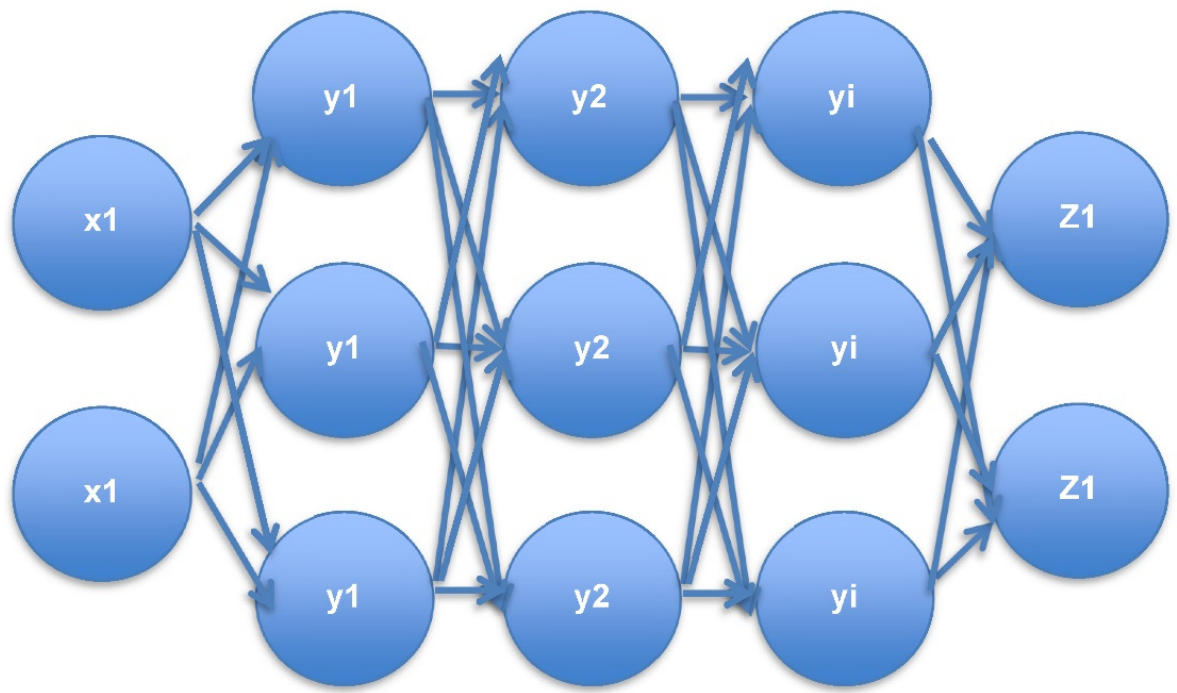
Figure 1. DNN multilayer perceptron for network traffic processing.